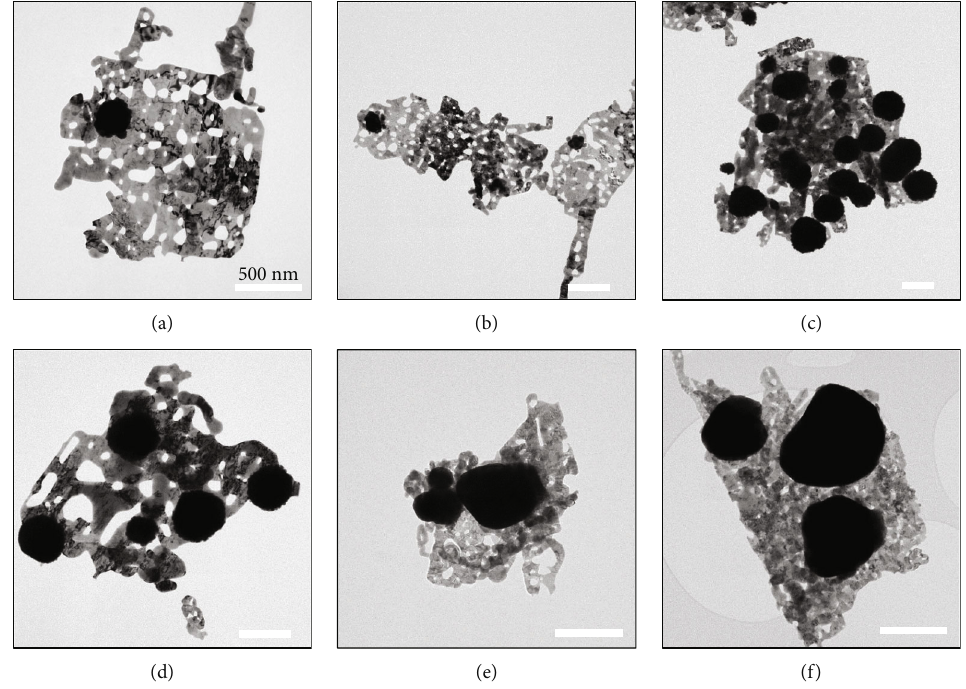
Figure 2: TEM images of the (a, b) 1, (c, d) 3, and (e, f) 5 at% Ag-functionalized porous ZnO